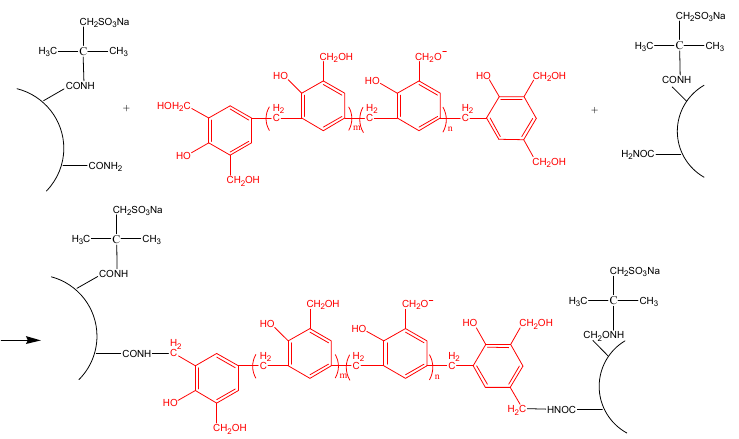
Figure 3. Crosslinking reaction of an AM-AMPS copolymer with water-soluble phenolic resin.